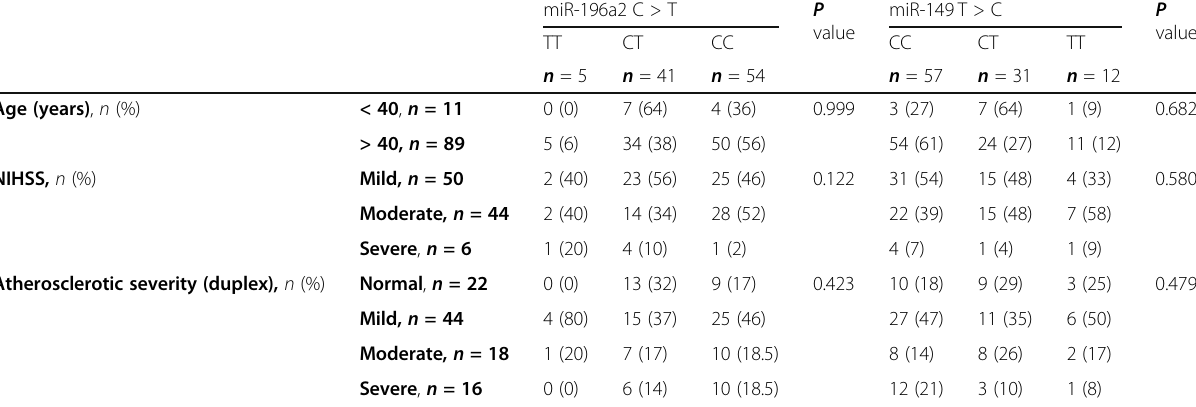
Table 3 Relation between genotypes, age and severity of impairment (NIHSS score and